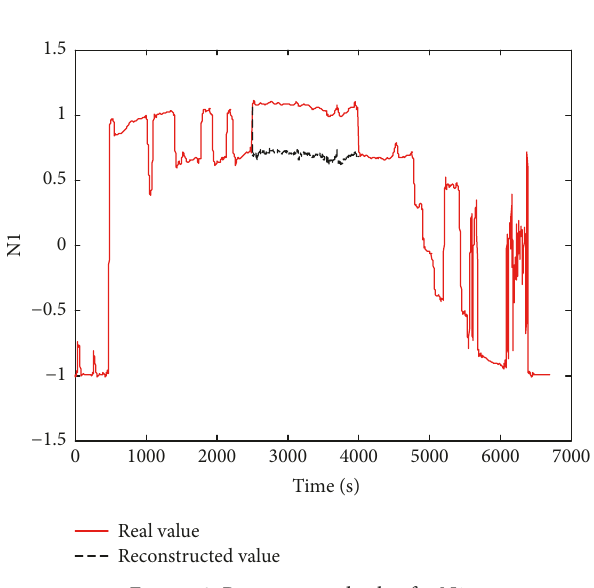
Figure 8: Reconstructed value for